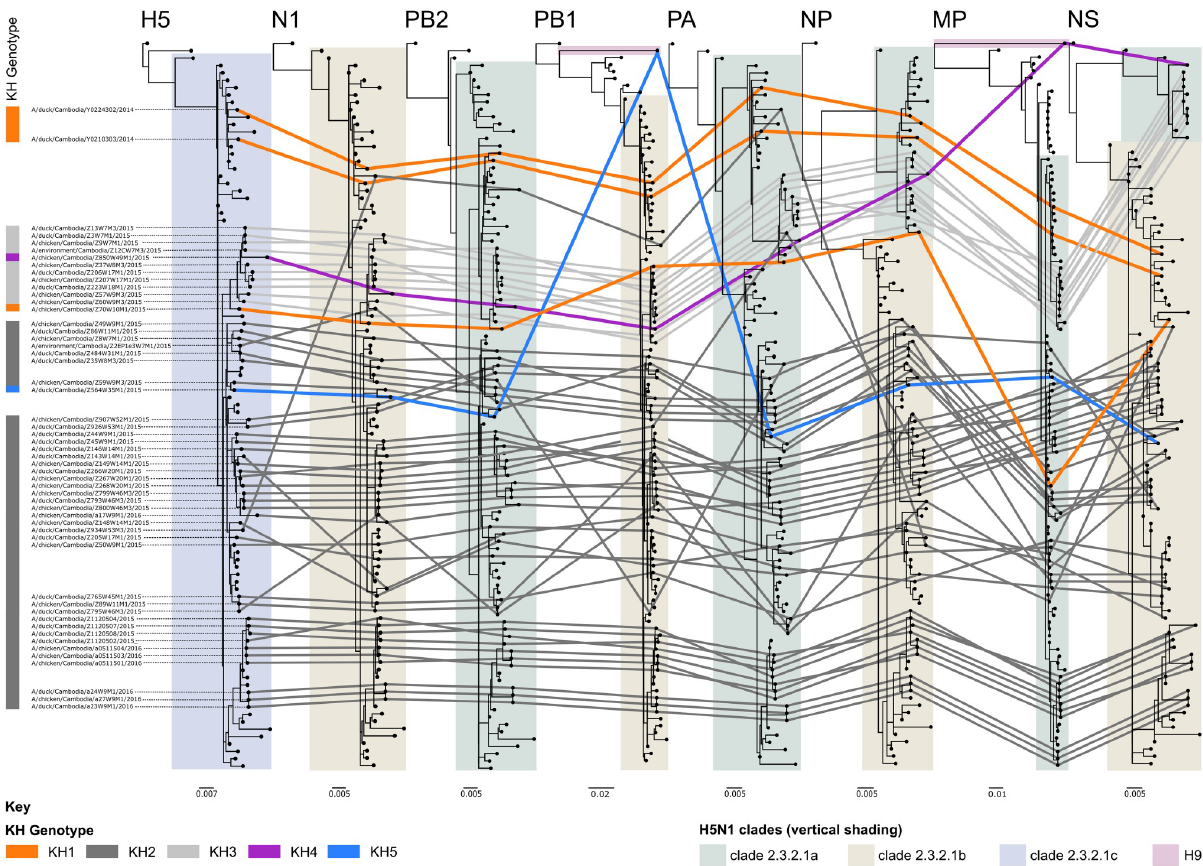
Fig 4. Phylogenetic congruence map of Cambodian A(H5N1) viruses. ML phylogenetic trees were produced for each genomic segment. The scale bars indicate the number of nucleotide substitution per site. For each Cambodian A(H5N1) virus, links have been drawn to connect phylogenetic position of individual viruses across all eight genomic segments. For visual clarity the links are colour coded based on viral genotypes. Viral designations and genotypes are indicated on the left side of the figure. The KH1 genotype is coloured orange, KH2 is dark grey, KH3 is light grey, KH4 is purple and KH5 in blue. Additionally, the putative ancestry of the HA, NA, MP and internal gene segments are shown by vertical shading of each ML tree. Clade 2.3.2.1a is shaded in green, 2.3.2.1b in brown, 2.3.2.1c in blue and A(H9N2) in mauve.